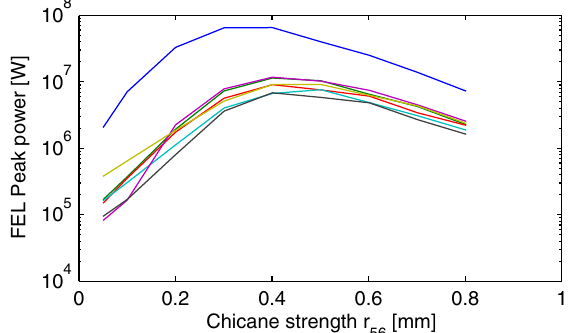
FIG. 15. FEL peak power at the undulator exit versus chicane strength for various quadrupole strength shifts: (blue) ideal, (dark green) þ 8% on PMQ 1, (red) þ 1% on PMQ 2, (light blue) þ 1% on PMQ 3, (purple) þ 8% on EMQ 1, (light green) þ 4% on EMQ 2, (black) þ 20% on EMQ 3. Beam transport simulation in the nonlinear case with BETA and sympletic 6D tracking without collective effects using the S2I-CM optics with r 11 ¼ r 33 ¼ 10 . FEL simulation with GENESIS.